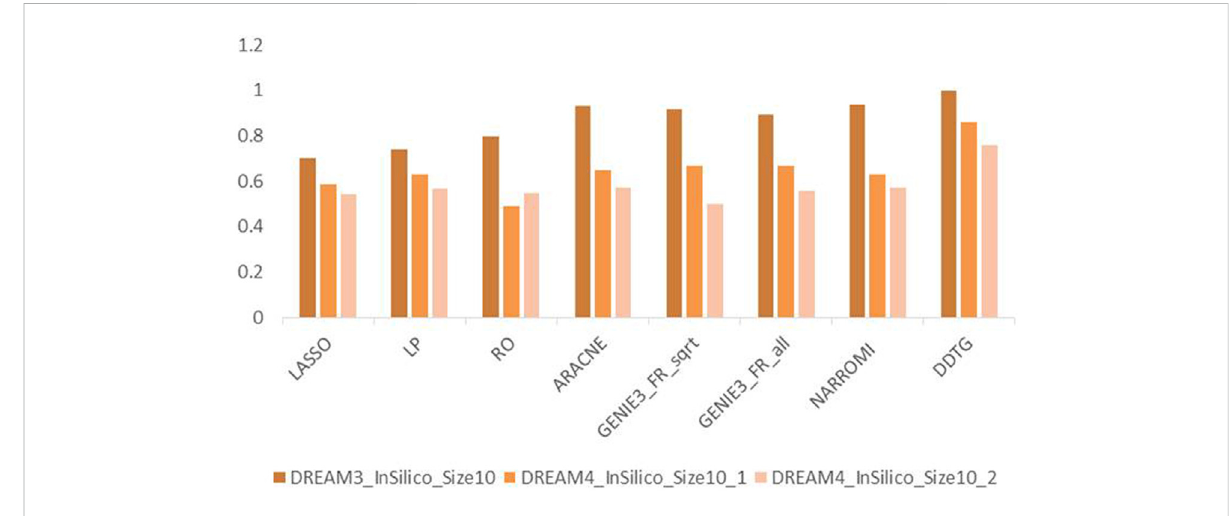
FIGURE 5 AUC comparison of methods on different networks with size